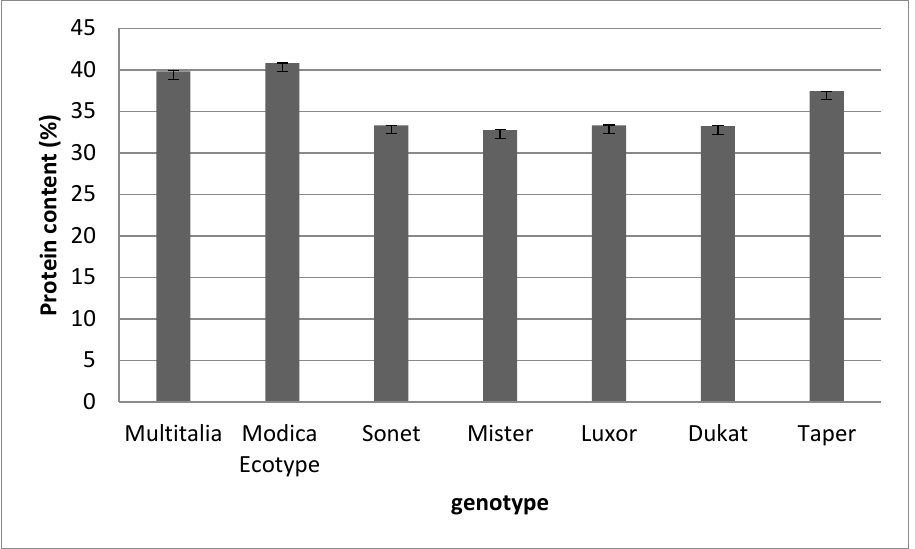
Figure 1. Protein content of the different Lupinus spp. genotypes. Data are presented as means ± standard deviation.